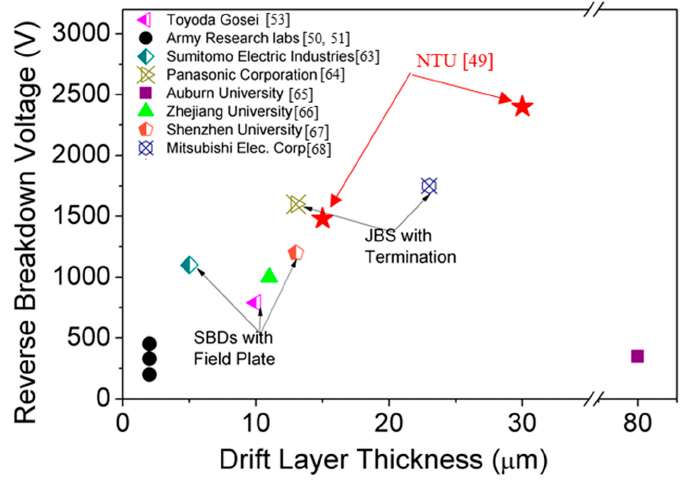
Figure 15. Benchmarking of measured reverse breakdown voltages of vertical GaN SBDs with state-of-the-art results.